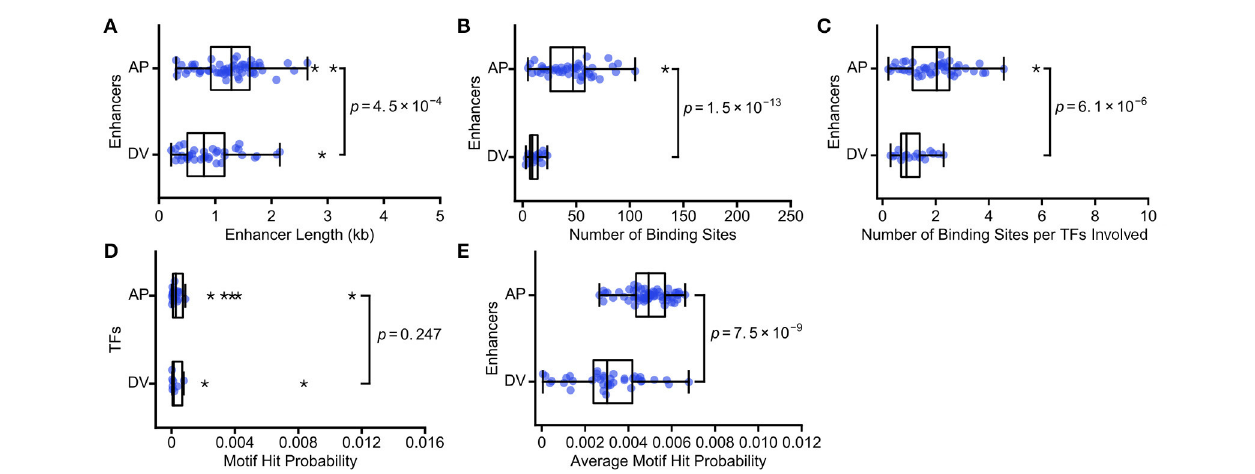
FIGURE 2 | The more complex AP axis is patterned by enhancers with more TF binding sites. We show the scatterplots and associated boxplots of (A) the length of AP and DV enhancers, (B) the number of TF binding sites predicted in AP and DV enhancers, (C) the number of TF binding sites normalized by the number of TFs involved, (D) the motif hit probability of TFs involved in AP and DV patterning, and (E) the average motif hit probability of AP and DV enhancers. These data are consistent with our hypothesis that enhancers carrying out more complex regulatory tasks will have more binding sites, in this case because AP enhancers are both longer and have lower average TF binding specificity. In all box plots, the boxes indicate the lower and upper quartiles, with the line within the box indicating the median. Whiskers extend to 1.5*IQR (interquartile range) plus or minus the upper and lower quartile, respectively, and the stars indicate outliers that fall outside the whiskers. P -values from Mann-Whitney rank tests are shown.